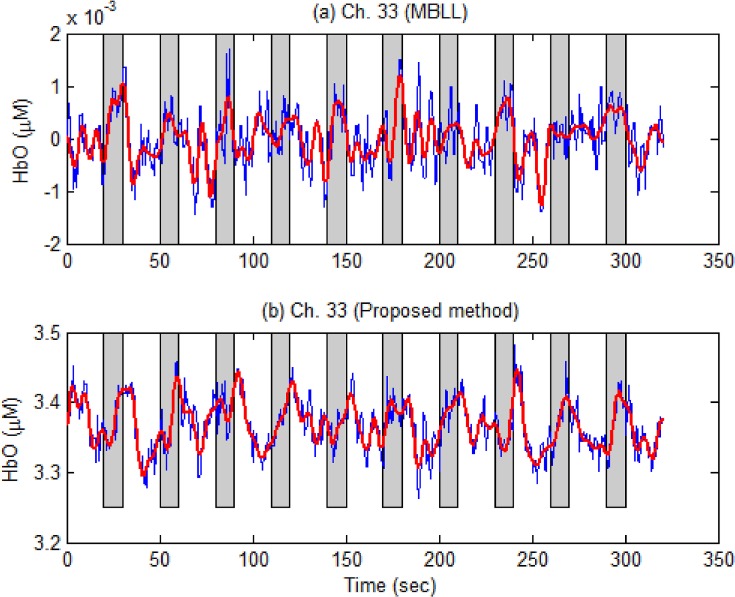
An example showing that the MBLL method cannot tell but the proposed method can tell (Ch. 33, Subject 5).(a) HbOs computed by the conventional MBLL method (blue thin curve: raw data, red thick curve: low-passed filtered); (b) HbOs obtained by the proposed method: In this case, the channel will be judged inactive by the MBLL method, while it will be judged active by the proposed method.